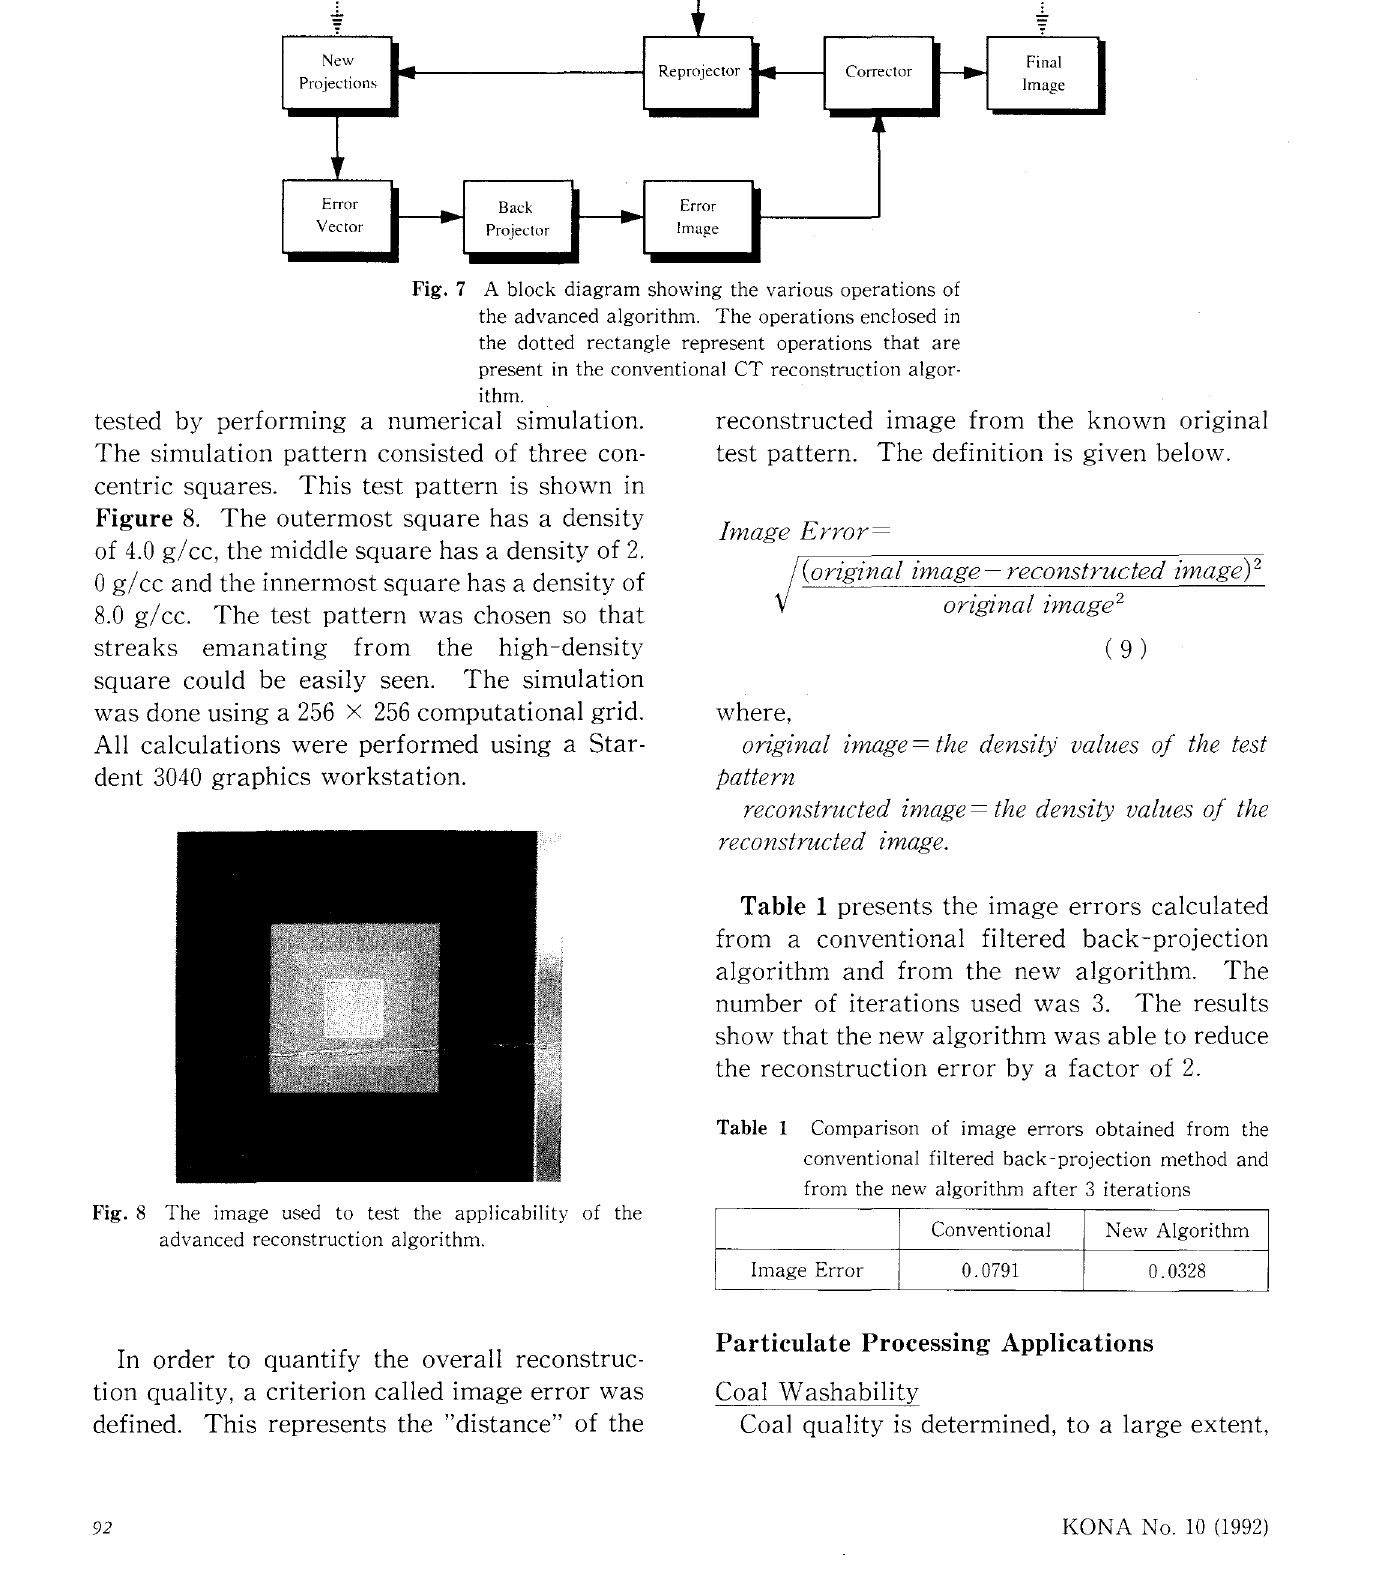
Fig. 8 The image used to test the applicability of the advanced reconstruction